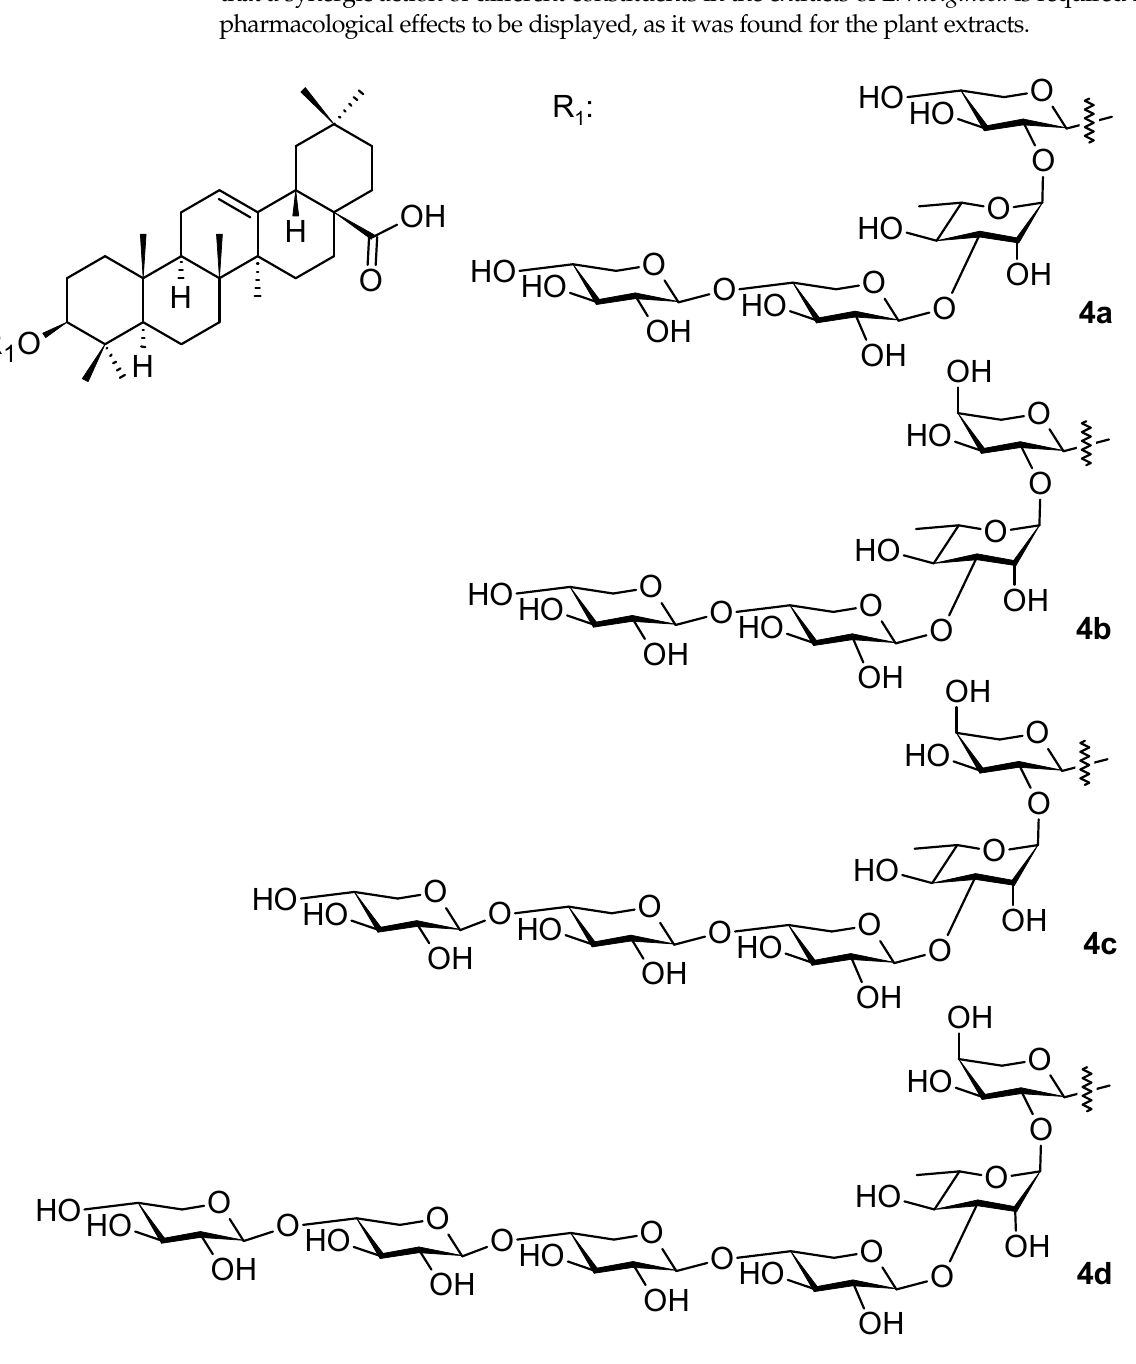
Figure 4. Oleanane-type triterpenoids found in the plants of the genus Weigela (part 2).